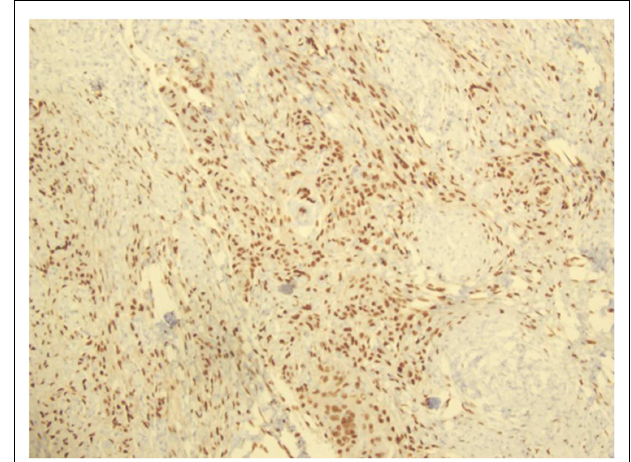
FIGURE 3 | Progesterone receptor antibody staining, showing the presence of PR in the specimen